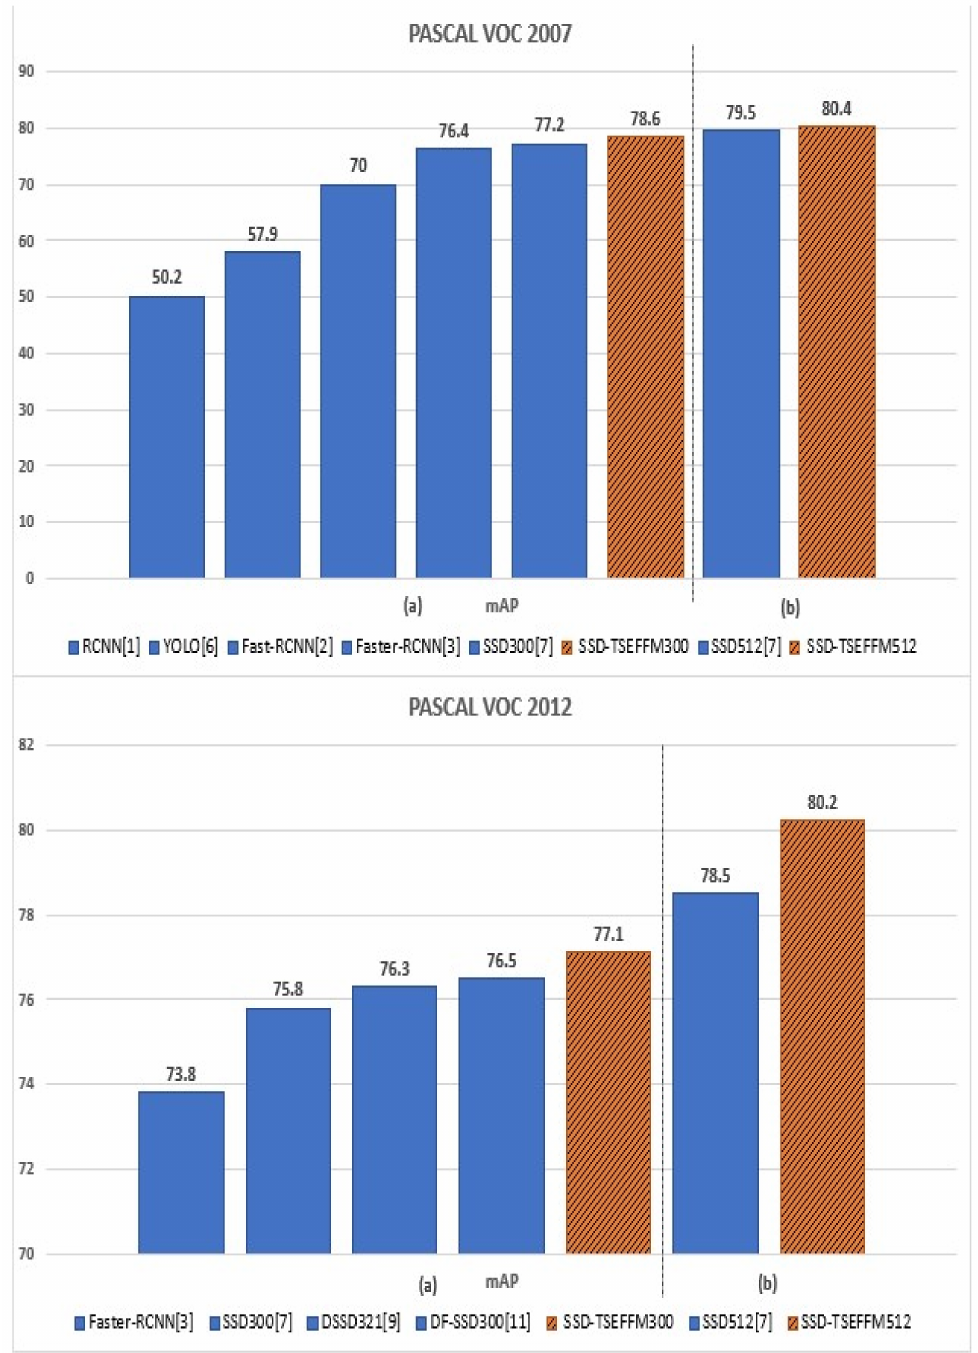
Figure 5. Diagram of mean average precision results tested on PASCAL VOC 2007 ( upper panel), 2012 ( lower panel) datasets. ( a ) depicts the result obtained with the input size of 300 × 300, and ( b ) shows the result of experiments with the input size of 512 ×